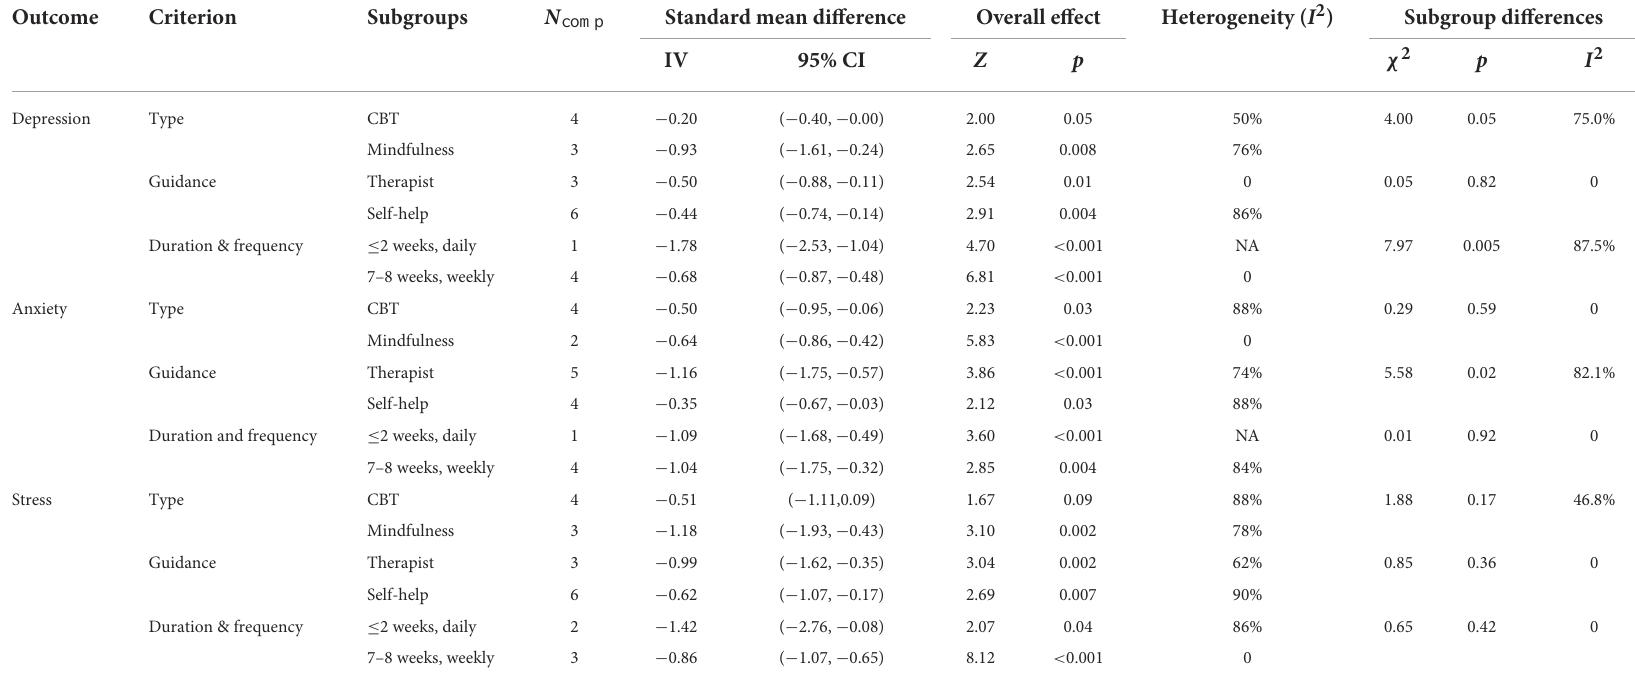
TABLE 4 Effect differences between subgroups in terms of depression, anxiety, and stress.